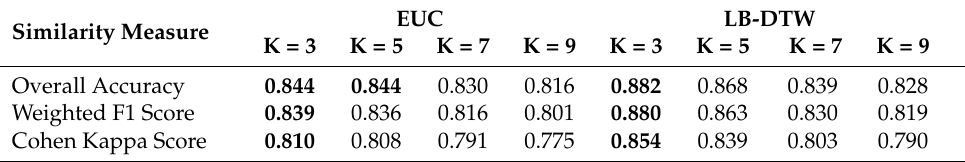
Table 5. Comparison of different K values for the first SITS grid.